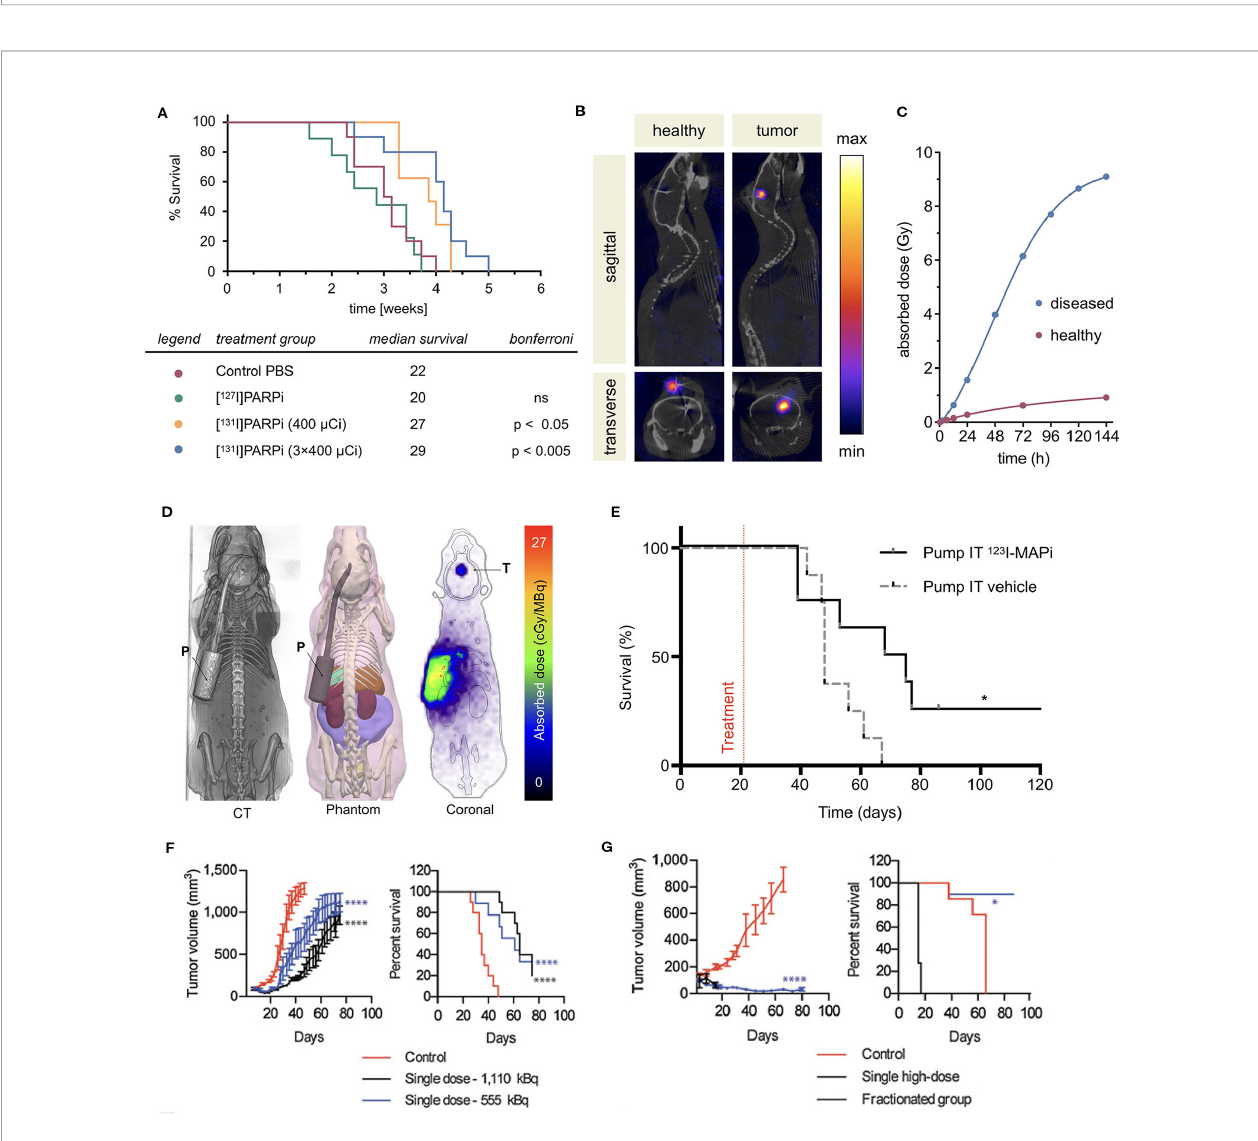
FIGURE 3 | PARP targeted radiotherapies. Radiolabeled PARP inhibitors in mouse models of cancer. (A) Survival plot and table of treatment groups with median survival of subcutaneous U87-p53 tumor-bearing mice. P = 0.0001. (B) SPECT/CT of orthotopic U87-p53 tumors during osmotic pump treatment of [ 131 I]PARPi at 72 hours. (C) Calculated absorbed dose to brain* during treatment. *Brain and tumor have been considered together as a single organ in organ level dose calculation. (Jannetti et al., 2018). (D) Dosimetry of the subcutaneous pump model showing CT, phantom, and Monte Carlo simulation of dose accumulation in the tumor. (E) Kaplan – Meier survival study of pump implanted mice shows an improvement of survival of 123 I-MAPi treated mice (n = 8) when compared to control (n = 8). *P < 0.05 (Pirovano et al., 2019). (F) Tumor growth and Kaplan – Meier curves for IMR-05 tumor - bearing mice (F) treated with single dose of 555 or 1,110 kBq of [ 211 At]MM4 (control vs . 555 kBq and 1,110 kBq mixed linear model p < 0.0001; control vs . 555 and 1,110 kBq survival Mantel – Cox test p < 0.0001, 555 vs. 1,110 kBq not signi fi cant, (G) and single high dose of 1,480 kBq vs . a fractionated dose of 370 kBq twice weekly for a cumulative dose of 1,480 kBq (control vs . fractionated mixed linear model p < 0.0001, fractionated vs . high dose not signi fi cant; survival Mantel – Cox test high dose vs . control p < 0.0001, fractionated vs . control p < 0.03 (Makvandi et al.,